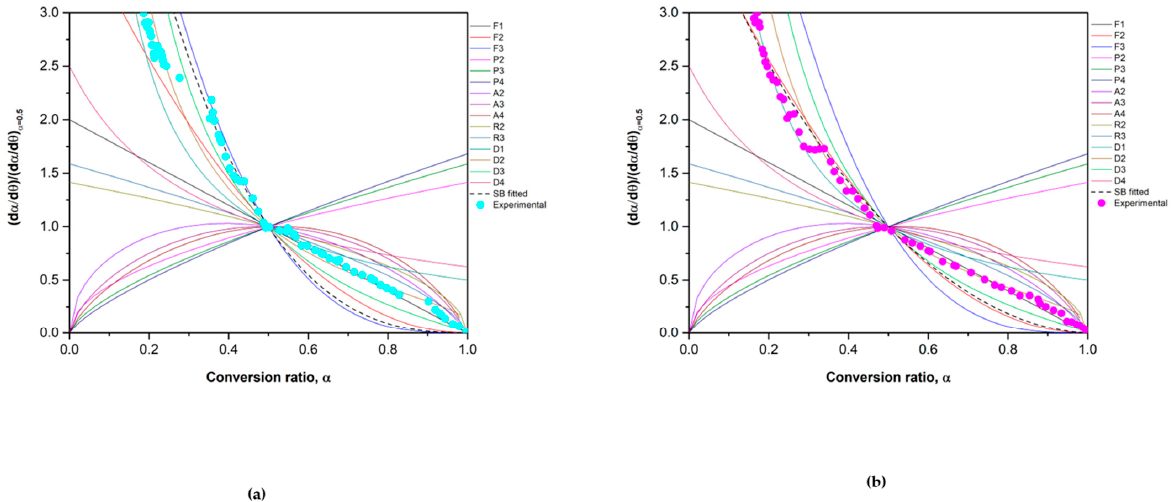
Figure 5. Theoretical master plots, SB fitted function and experimental results of ( a ) Co 2.4 Ni 0.6 O 4 and ( b ) 0.5% SiO 2 /Co 2.4 Ni 0.6 O 4 using a heating ramp of 20 °C/min.